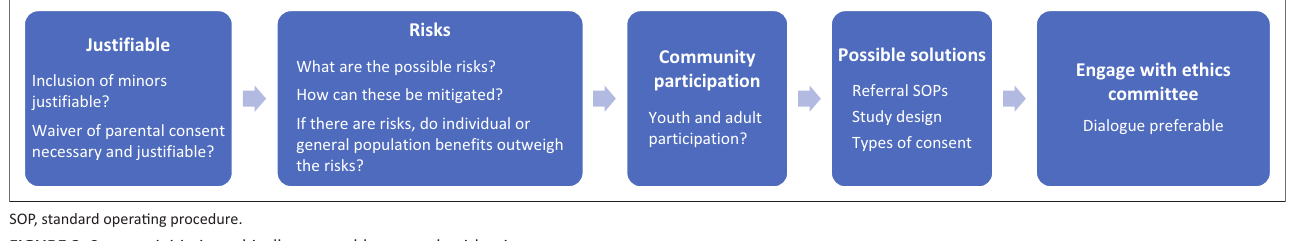
FIGURE 2: Steps to initiating ethically acceptable research with minors.